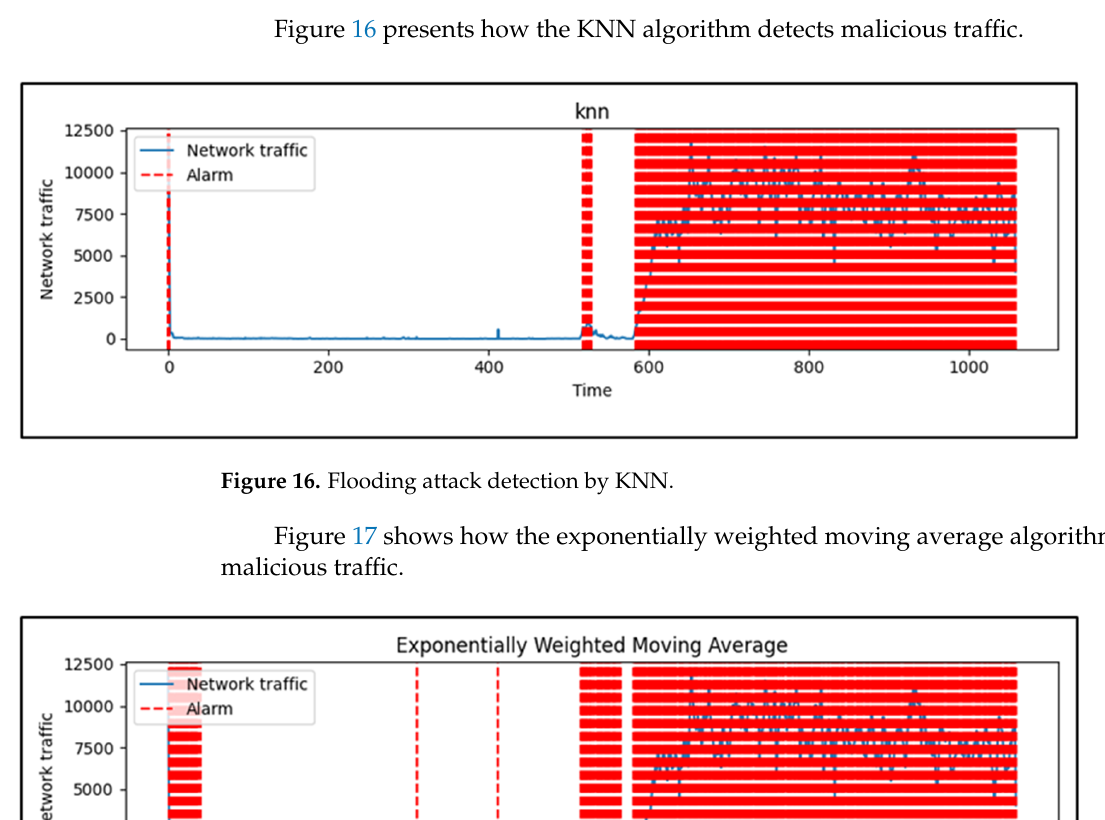
Figure 15. Network flooding attack traffic.